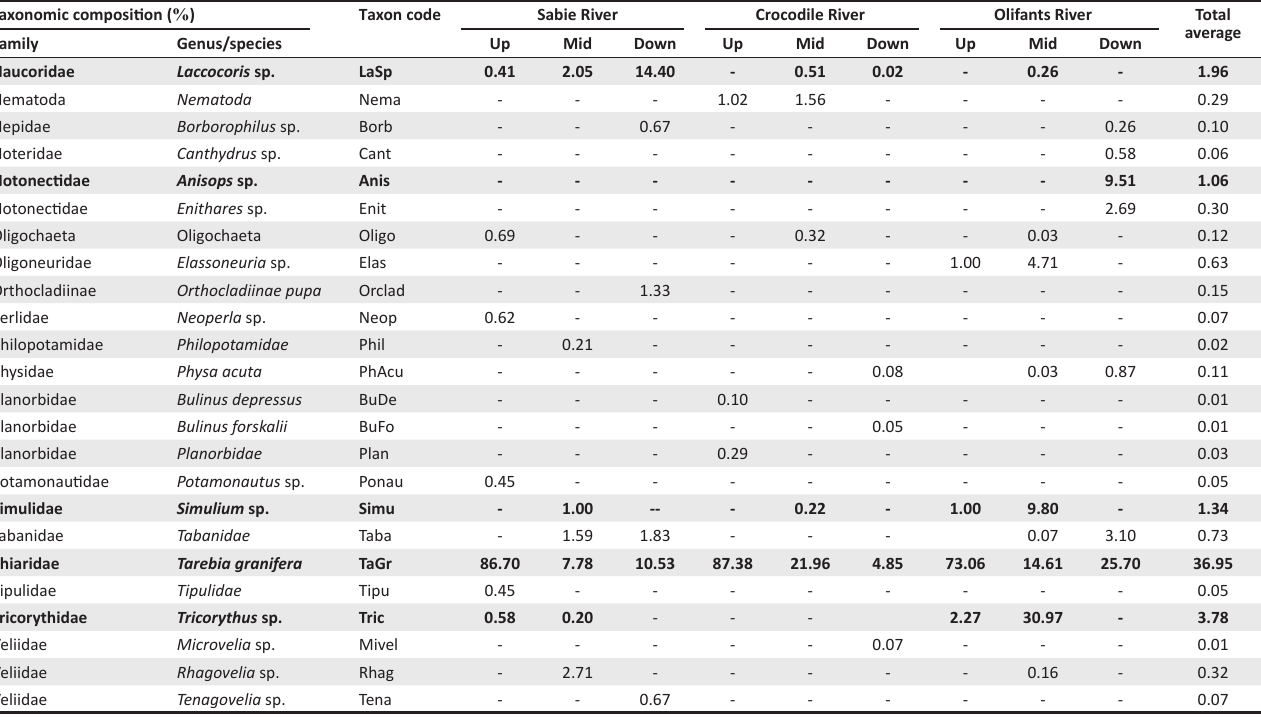
TABLE 1-A1 (continous ...): Relative taxonomic composition of the macrobenthic invertebrate community dwelling the riverbed of three rivers flowing through the Kruger National